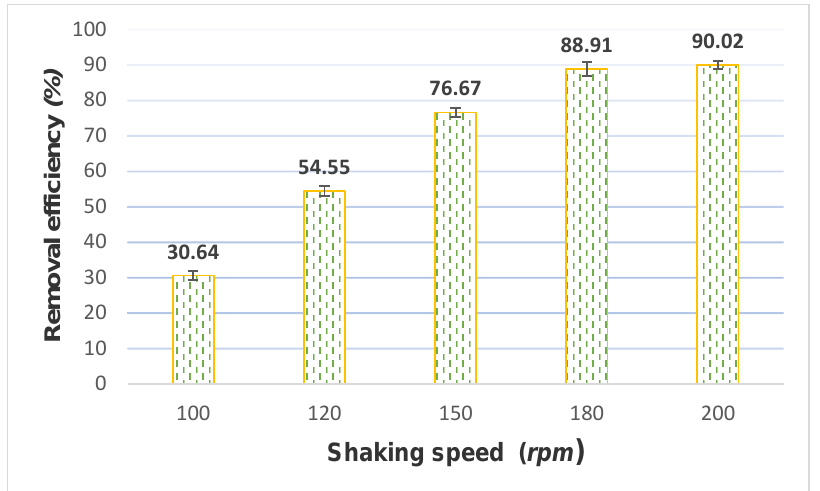
Figure 9. The effect of shaking speed on the phenol removal efficiency of Fe-Cu material.